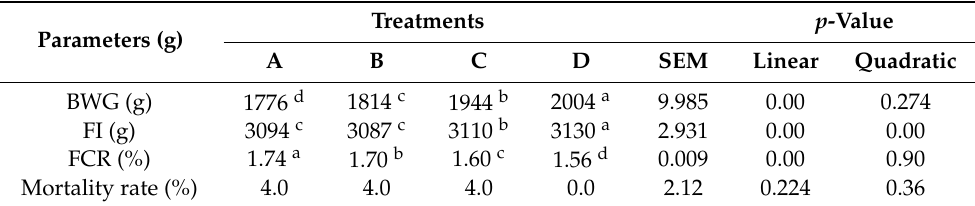
Table 3. E ff ect of biodegradation agent supplementation on growth performance of broilers during the Hoarder phase (1–35 days) ( n = 5).